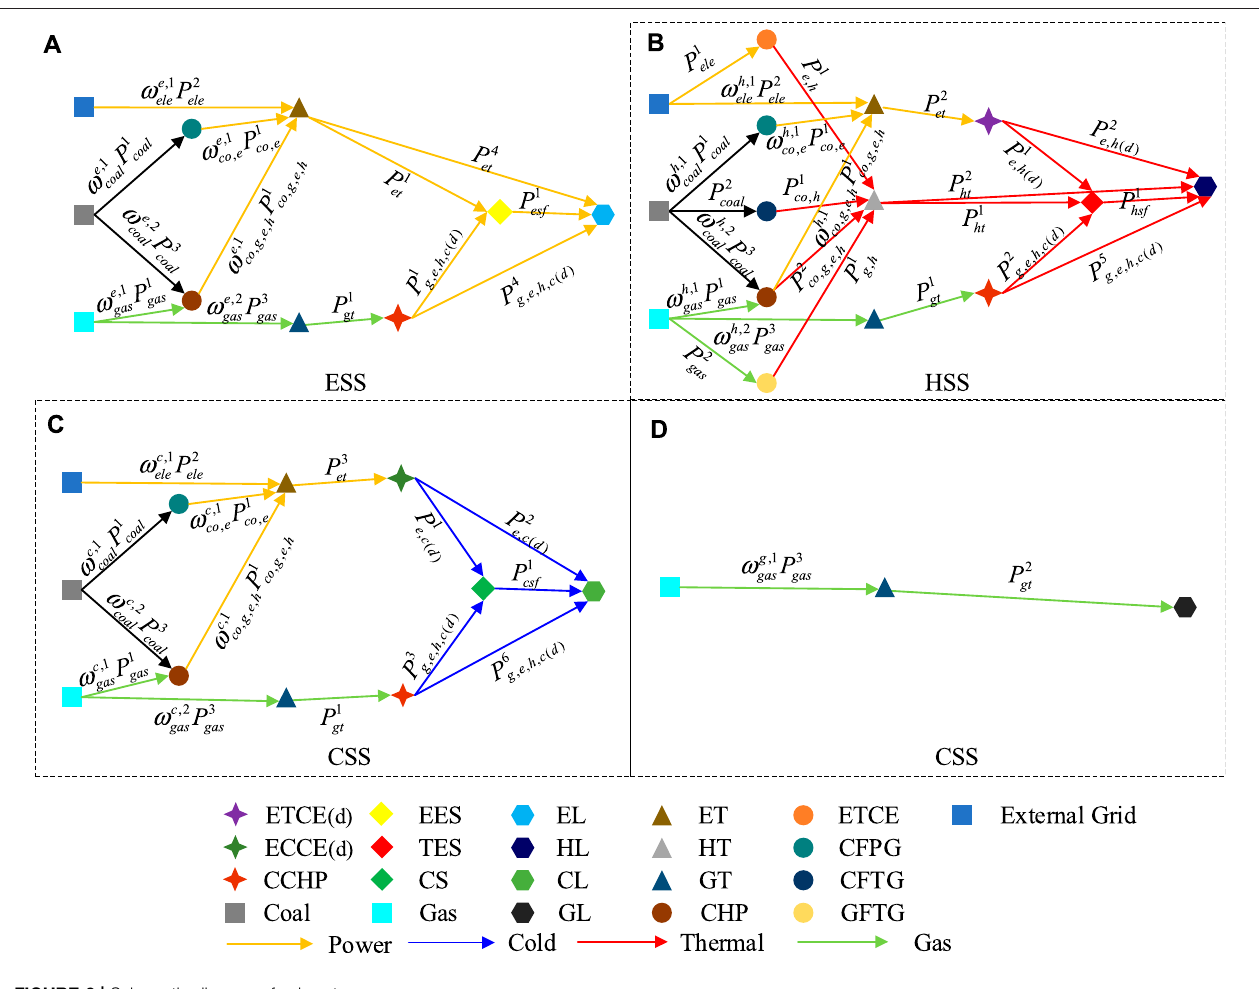
FIGURE 2 | Schematic diagram of subsystems.